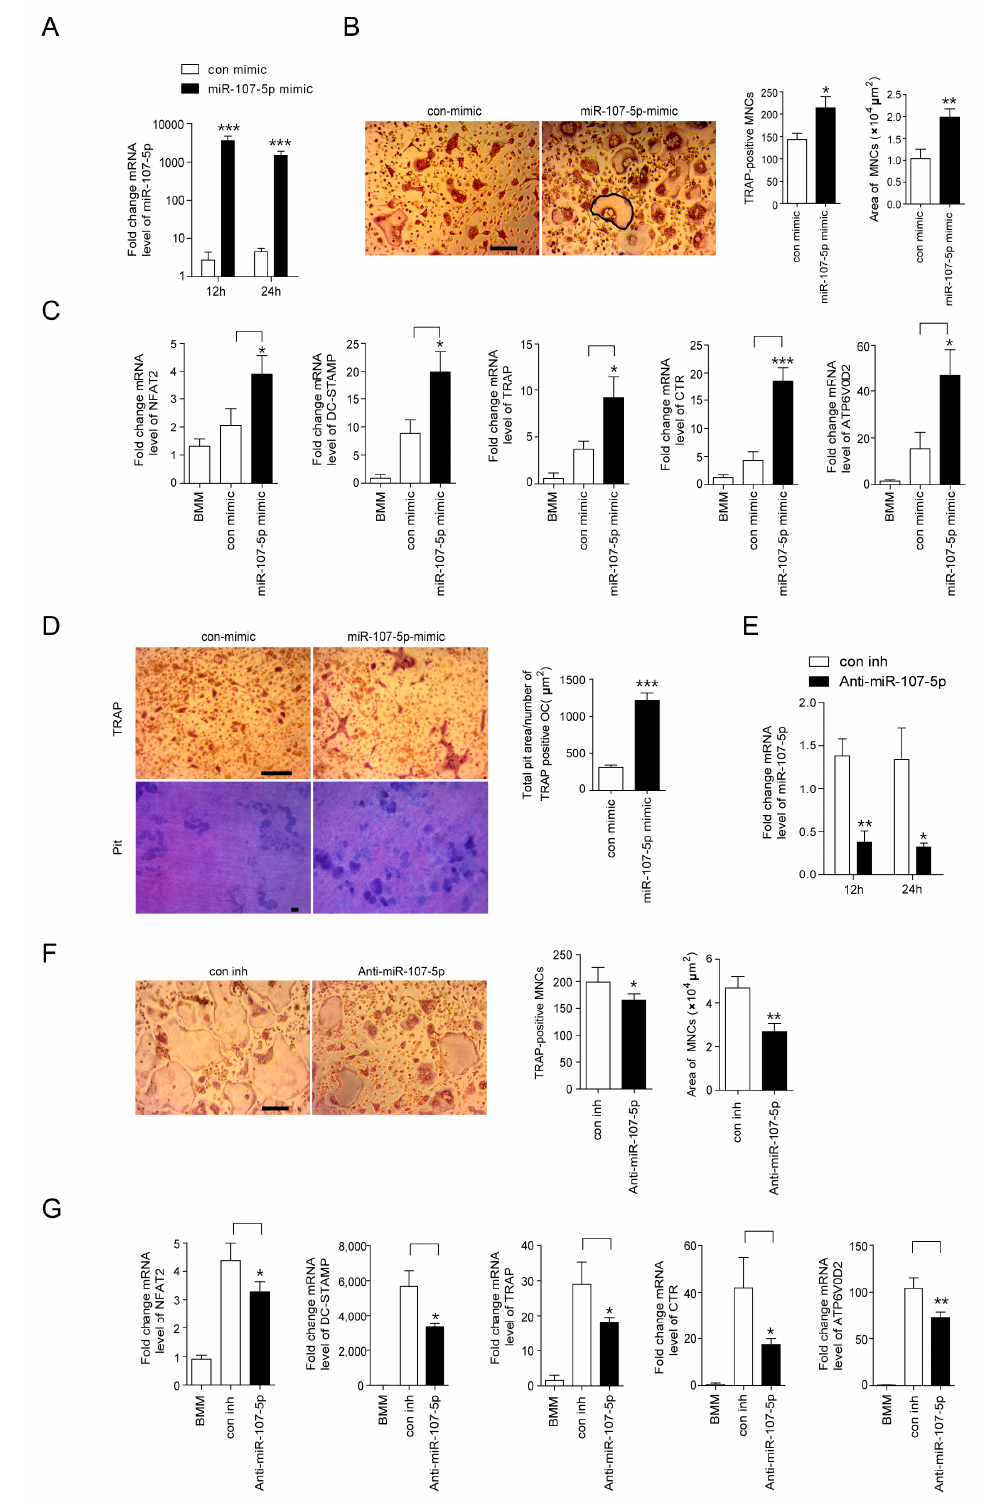
Figure 2. The expression level of miR-107-5p regulates osteoclast (OC) differentiation. BMMs were prepared, incubated with M-CSF (30 ng/mL) and RANKL (40 ng/mL) for 48 h, and transfected with 30 nM of miR-107-5p mimic or con mimic ( A – D ). BMMs were prepared, incubated with M-CSF (30 ng/mL), RANKL (40 ng/mL), and 7-KC (7 μ M) for 48 h, and transfected with 30 nM of anti-miR-107-5p or con inh ( E – G ). After the indicated time points, total RNA was analyzed by qPCR to quantify the expression of miR-107-5p. The expression levels of BMM ( A , E ) were set to 1. Cells were incu- bated for 17 h and fixed to analyze tartrate-resistant acid phosphatase (TRAP)-positive OCs ( B , F )